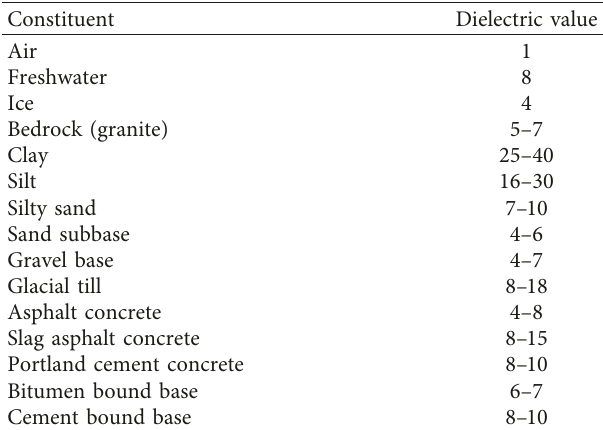
Table 2: Dielectric values of the typical pavement soil and layer